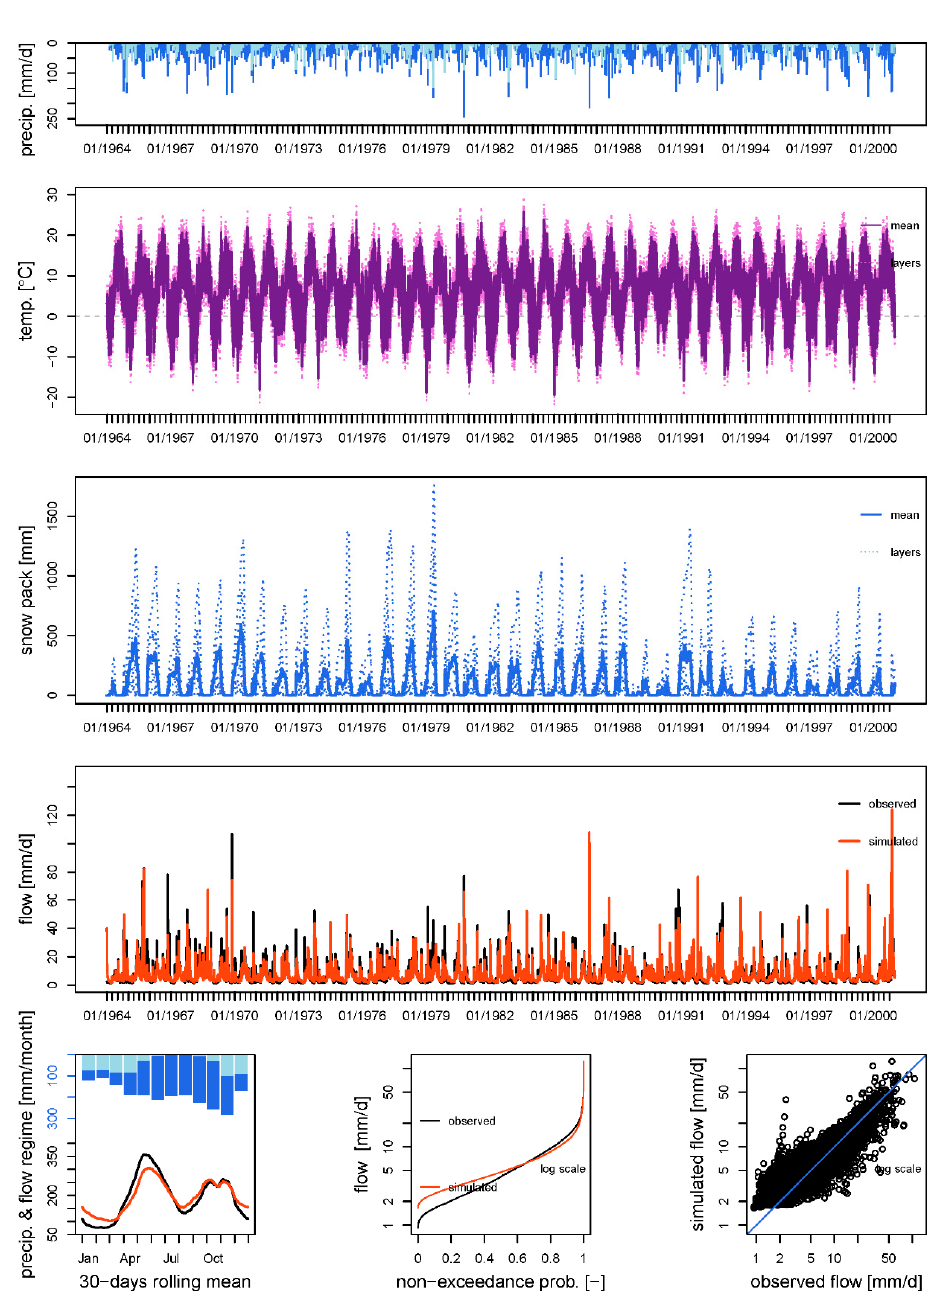
Figure 2. Modelling results for the So č a River case study for the calibration period. The upper four panels show precipitation, air temperature, snow pack, and flow (observed and modelled) values. mean, non- exceedance probability, and a scatter plot showing simulated and observed flow